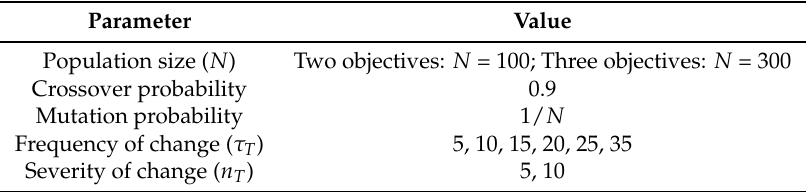
Table 2. Public parameter settings in the experiments.